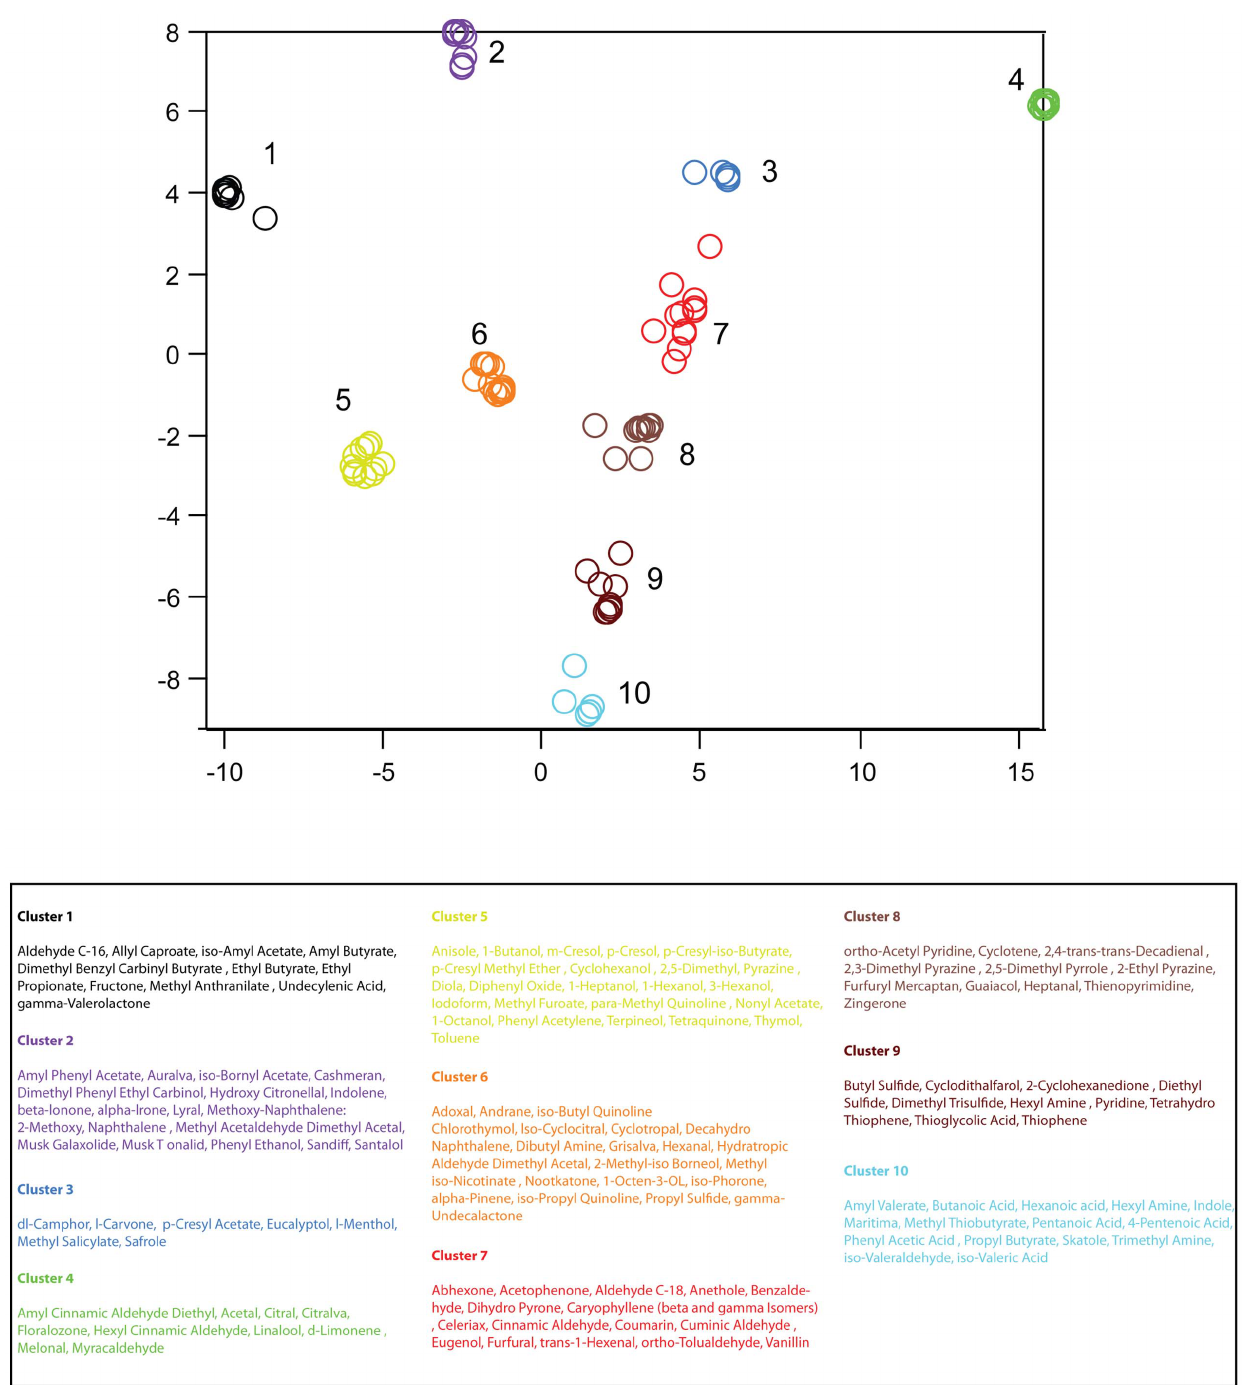
Figure 8. Two-dimensional embedding of the odorant-space, H . Results of stochastic neighbor embedding (see text) applied to the similarity matrix for H . As in figure 7, axis units are arbitrary, but preserve neighbor relationships observed in the full-dimensional space, H . Clusters were identified by eye, and odorants composing each cluster are listed in the table below.